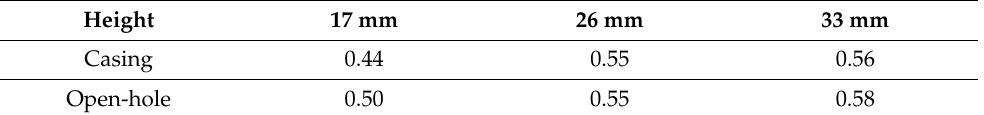
Table 4. The influence of cuttings on the friction coefficient of drill pipe with different coating heights.